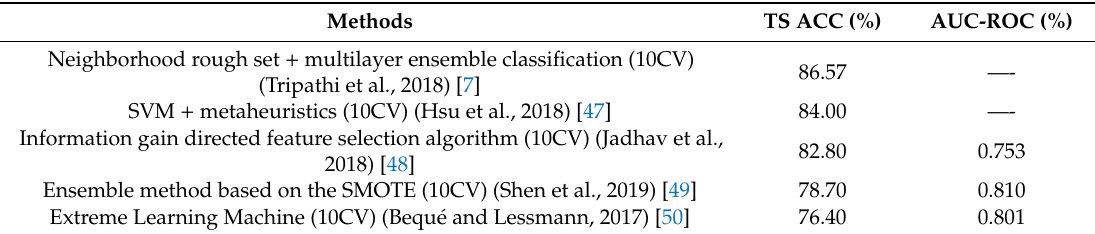
Table 4. Comparison of the performance of recent high-accuracy classifiers for the German credit scoring